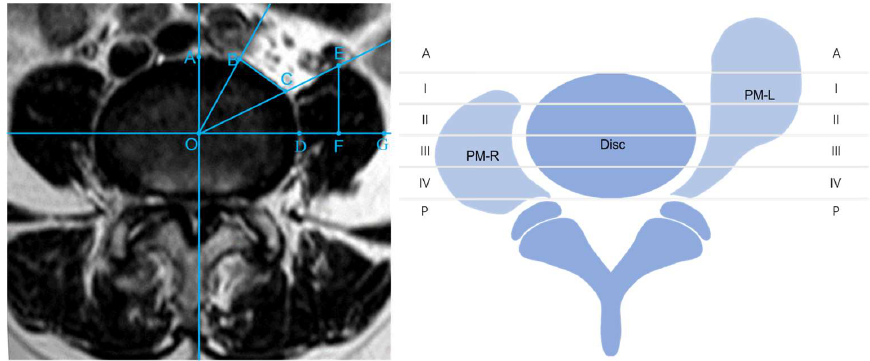
Figure 1. Measurement standards and Moro zones. ( left ): Disc midpoint (O); disc sagittal diameter, DSD (OA); operating window, OW (BC); psoas major transverse diameter, PMTD (DG); psoas major sagittal diameter, PMSD (EF). ( right ): The disc was divided into Zones A, I, II, III, IV, and P s. The psoas major muscles were divided according to the positions of their anterior borders. The left psoas major with a teardrop shape was located in Moro Zone A. The right psoas major with a normal shape was located in Moro Zone I.